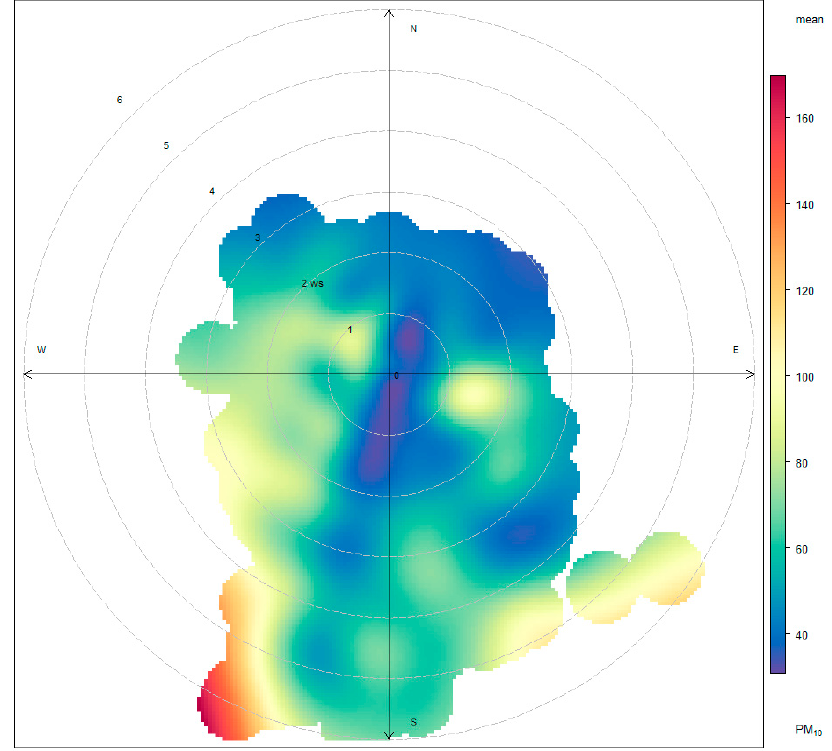
Figure 8. Mean concentrations of PM 10 in relation to wind direction and speed.